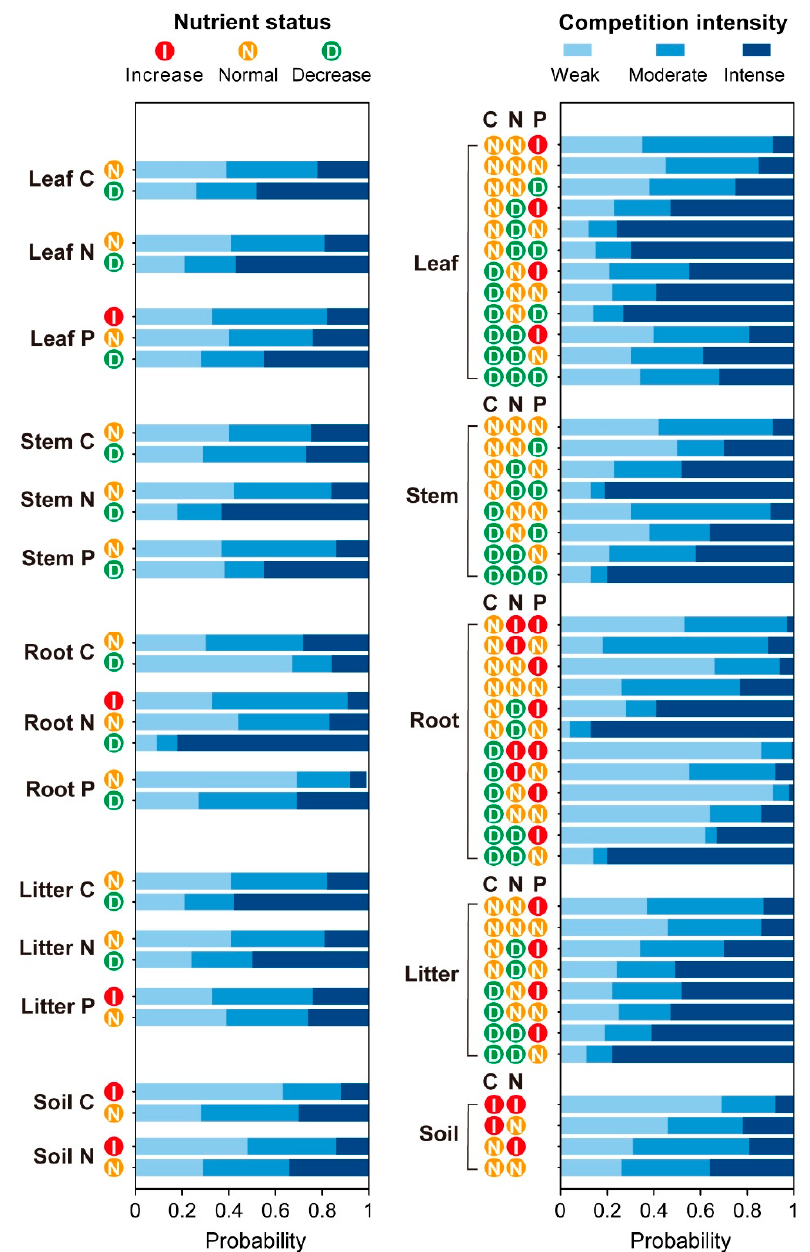
Figure 6. The predicted probabilities of the competition intensity under the combination of different observed nutrient statuses of the rubber leaves, stems, roots, litter, and soil. Red, yellow, and green pies indicated the possible nutrient status (i.e., increase, normal, and decrease status, respectively) of leaf, stem, root, litter, or soil. The baby-blue, royal-blue, and dark-blue bars indicate the probabilities of weak competition, moderate competition and intense competition, respectively.